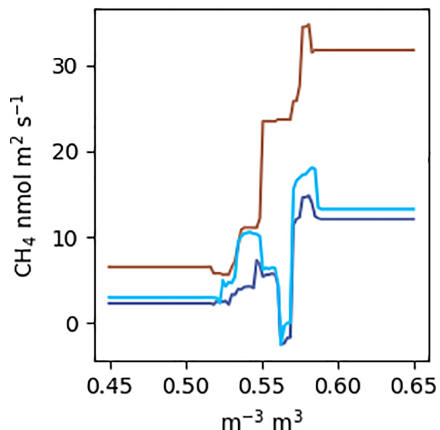
Figure A2. F CH estimated by a RF using the same factors as the 4 NN model. The colours correspond to the scenarios in Fig. 5a. VWC was estimated over the range from 0.45 to